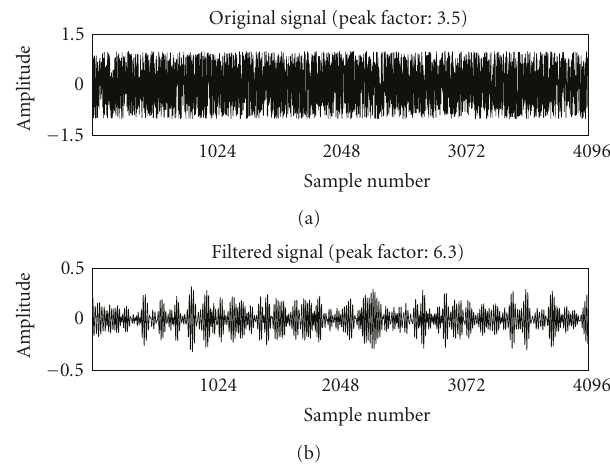
Figure 1: A noise signal (a) and the result of filtering it through a bandpass filter whose passband corresponds to a typical noise reduction subband